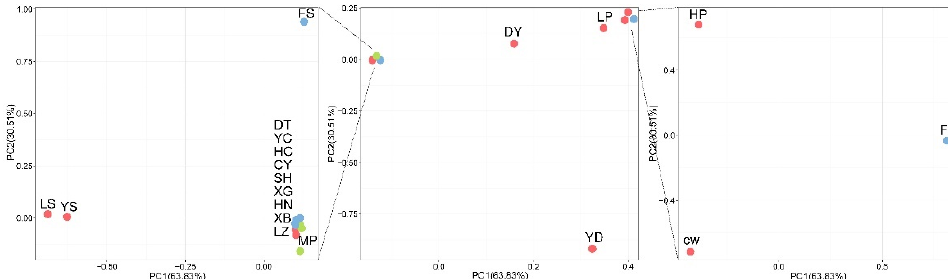
Figure 5. Principal component analysis of the first two principal components. Point colors indicate isolate origins: red represents isolates from the subtropical zone; green represents isolates from the warm temperate zone; and blue represents isolates from the mid-temperate zone.